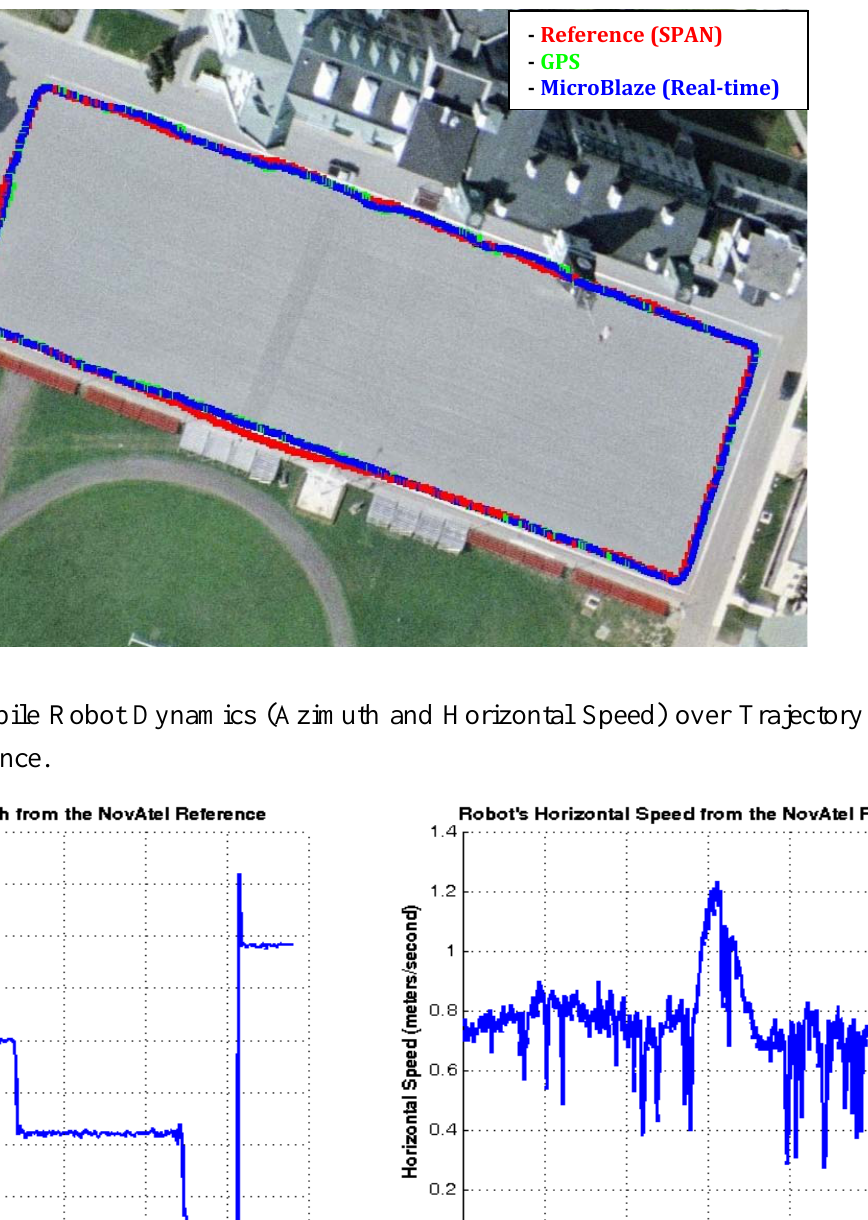
Figure 11. Mobile Robot Trajectory (1): Open Sky Area, with no Natural or Simulated GPS Outages.